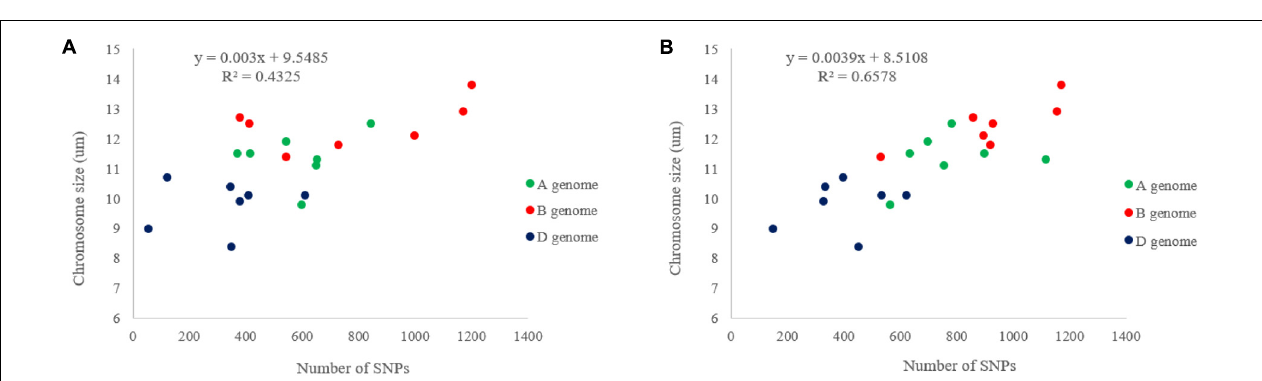
FIGURE 2 | Relationship between numbers of SNPs per chromosome and chromosome physical size estimated in (A) CSSS and (B) W7984